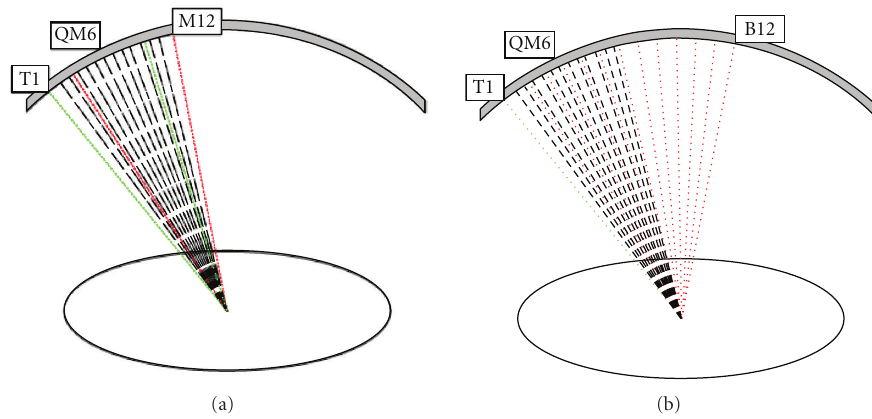
Figure 13: Time domain solutions for a single-simulated point target corresponding to the use of (a): IFFT k of second-order ( K φ > (cid:27) K φ ) Fourier domain region only and, (c): IFFT k Fourier domain region only, (b): IFFT k φ , k f domain regions. (The units, although not important to the figure, are nanoseconds on the x -axis and degrees on the y -axis.)